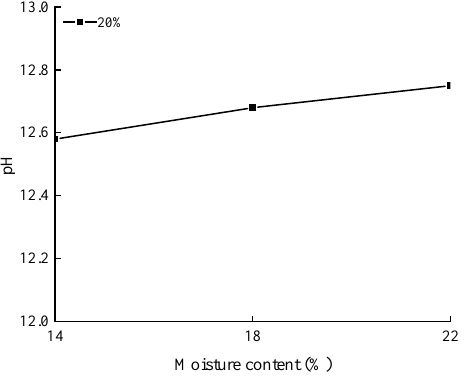
Figure 5. The pH curves of lime soils with different moisture contents.